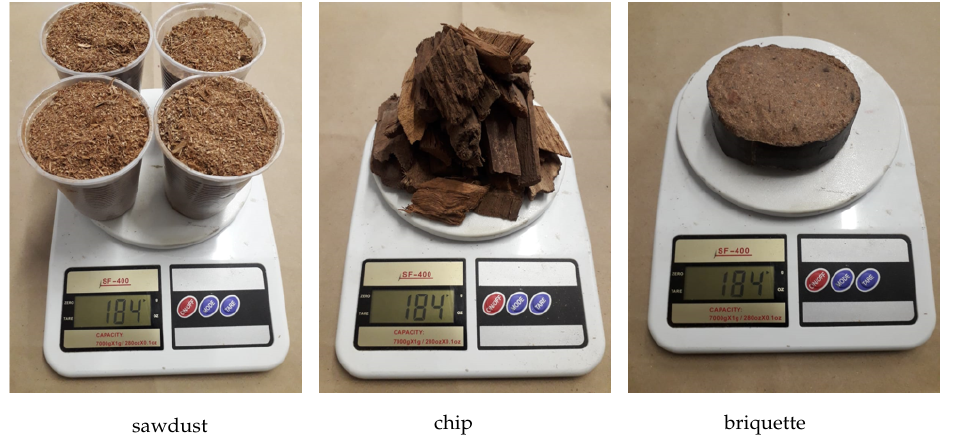
Figure 3. The same amount of biomass in bulk format and in its compacted